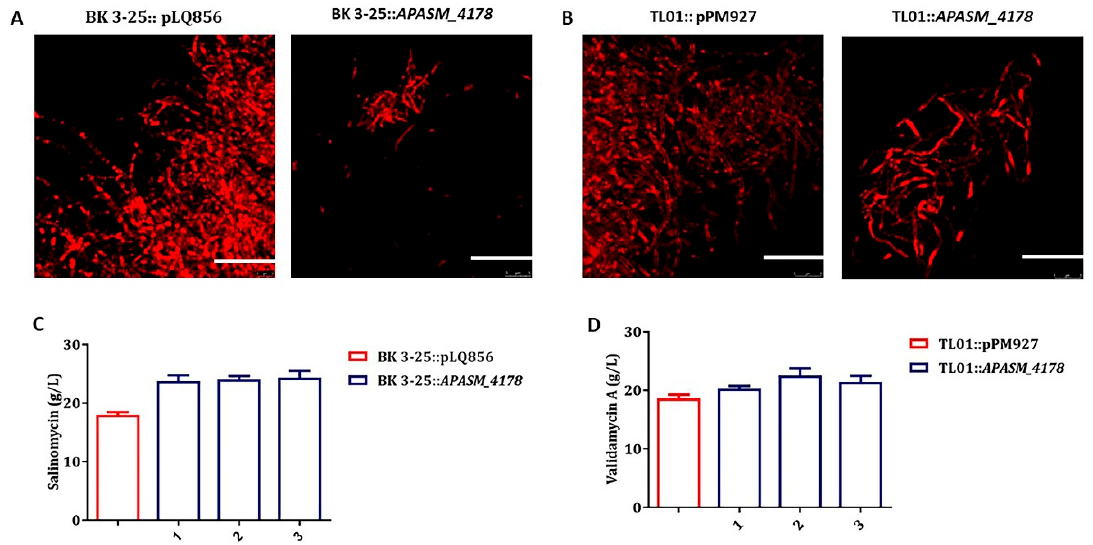
Figure 5. Overexpression of the subtilisin-like serine peptidase gene APASM_4178 in salinomycin-producing S. albus BK 3-25 and validamycin-producing S. hygroscopicus TL01. ( A ) Effect of APASM_4178 overexpression on the mycelial morphology of S. albus BK 3-25. Scale bars: 10 μ m. Magnification, 2,500×; ( B ) Effect of APASM_4178 overexpression on the mycelial morphology of S. hygroscopicus TL01. Scale bars: 10 μ m. Magnification, 2,500×; ( C ) Effect of APASM_4178 overexpression on salinomycin yield of S. albus BK 3-25. pLQ856: vector plasmid. Three mutant strains were randomly selected. Error bars: mean ± SD ( n = 3 biological replicates); ( D ) Effect of APASM_4178 overexpression on validamycin yield of S. hygroscopicus TL01. pPM927, vector plasmid. Three mutant strains were randomly selected. Error bars: mean ± SD ( n = 3 biological replicates).